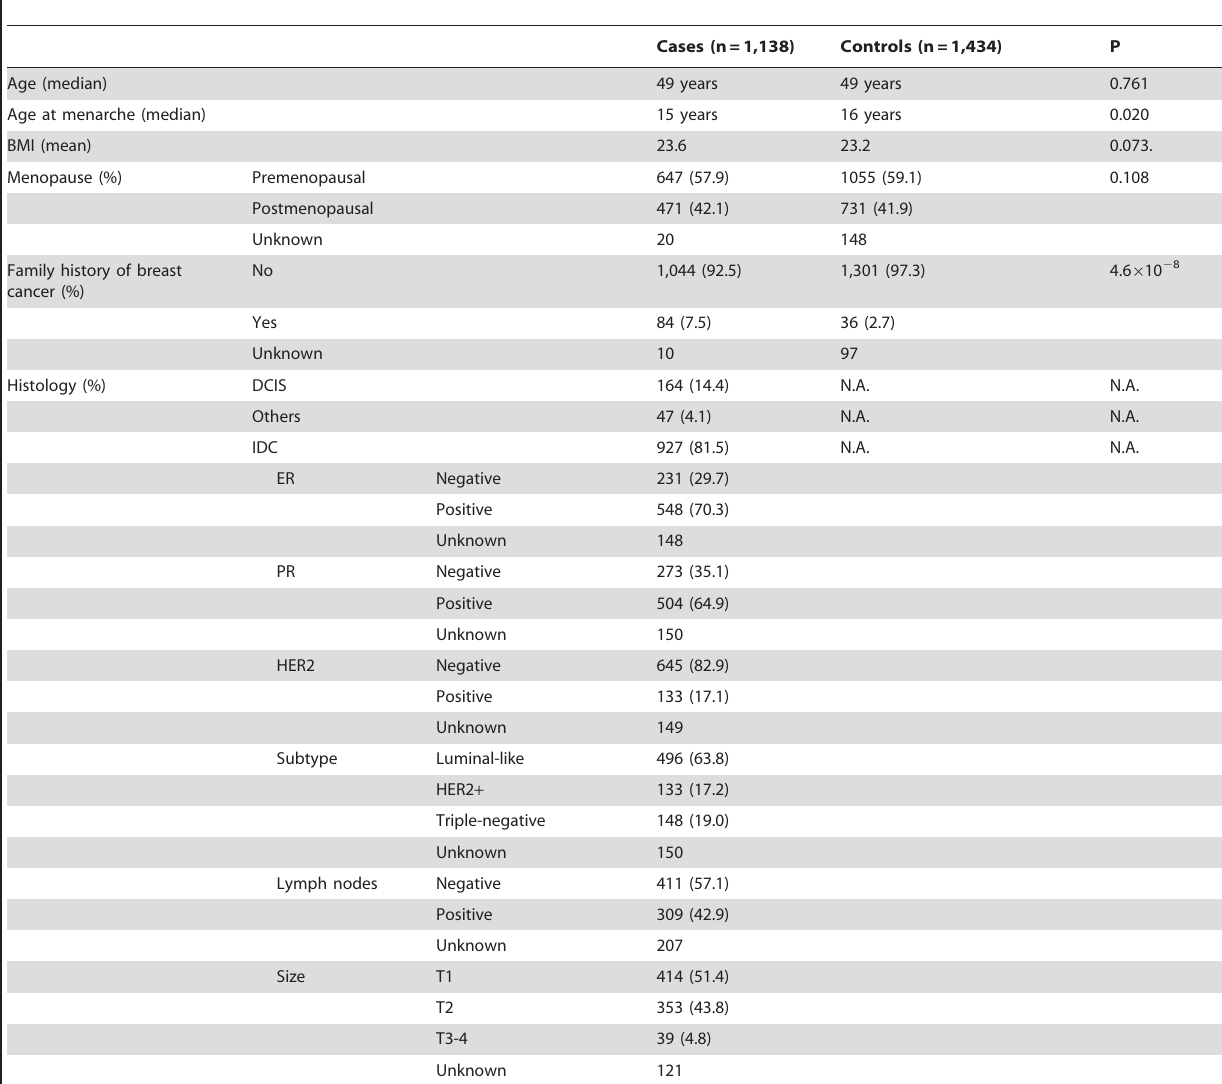
Table 1. Summary characteristics of the participants in the first